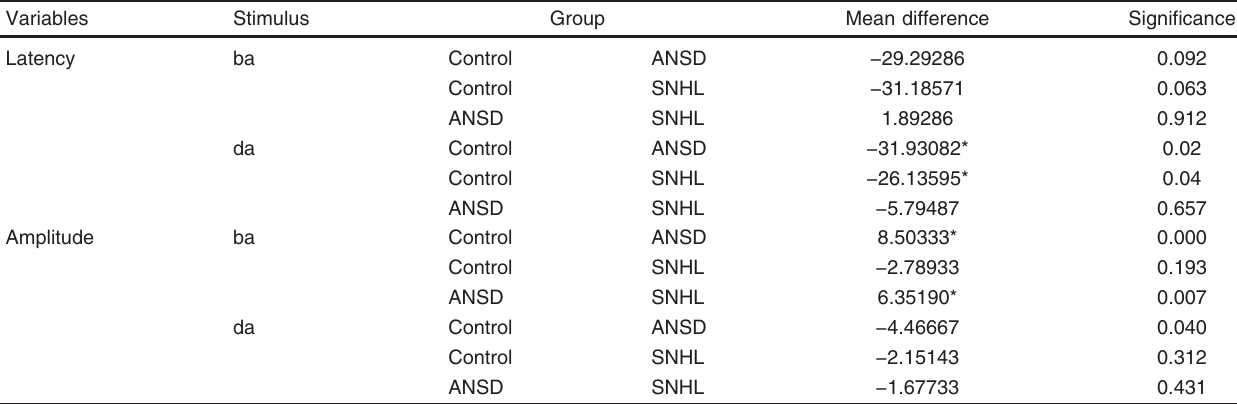
Table 4 Post-hoc test for the P1 latency and amplitude difference between the groups in the initial evaluation Variables Stimulus Group